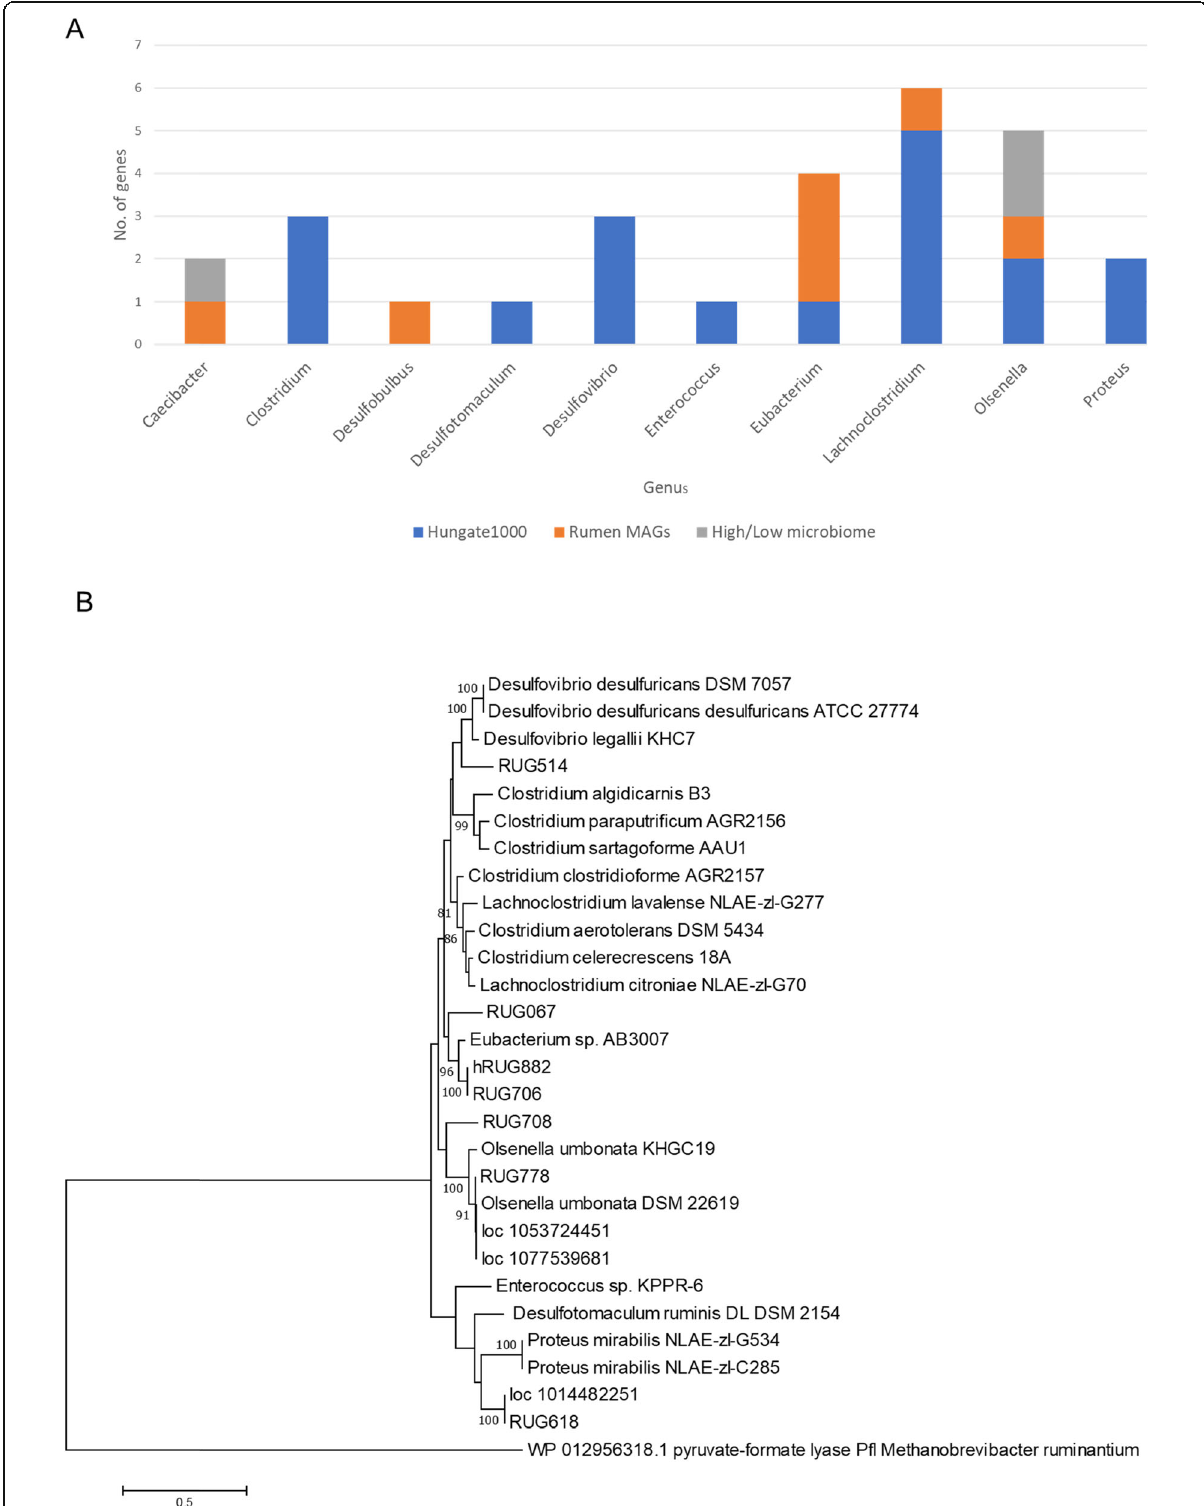
Fig. 1 Choline TMA lyase ( cutC ) gene abundance and diversity in a combined rumen metagenome and metatranscriptome dataset, metagenome-assembled genomes and Hungate1000 bacterial genomes ( a ), and a phylogenetic tree showing the relationships of CutC protein sequences from all these sources ( b